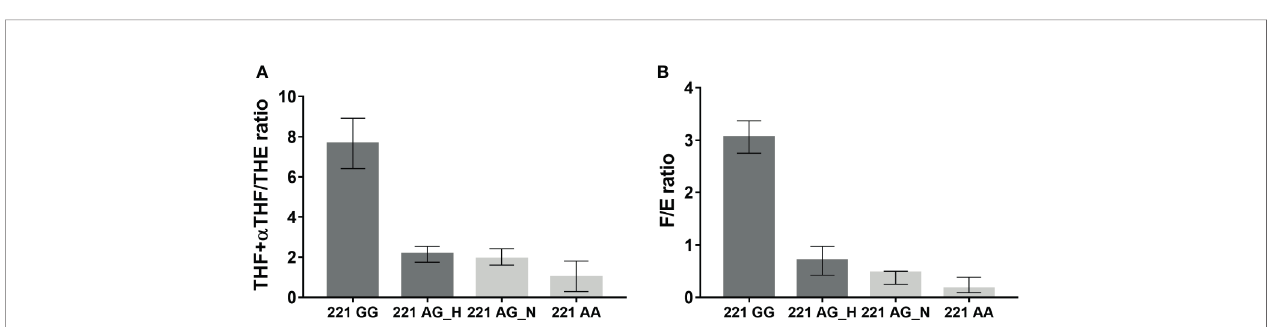
FIGURE 2 | THF+allo-THF/THE (A) and F/E (B) ratios in family affected by AME according to genotype (GG homozygous, AG heterozygous, AA wild type) and hypertensive status (H, Hypertensive; N,